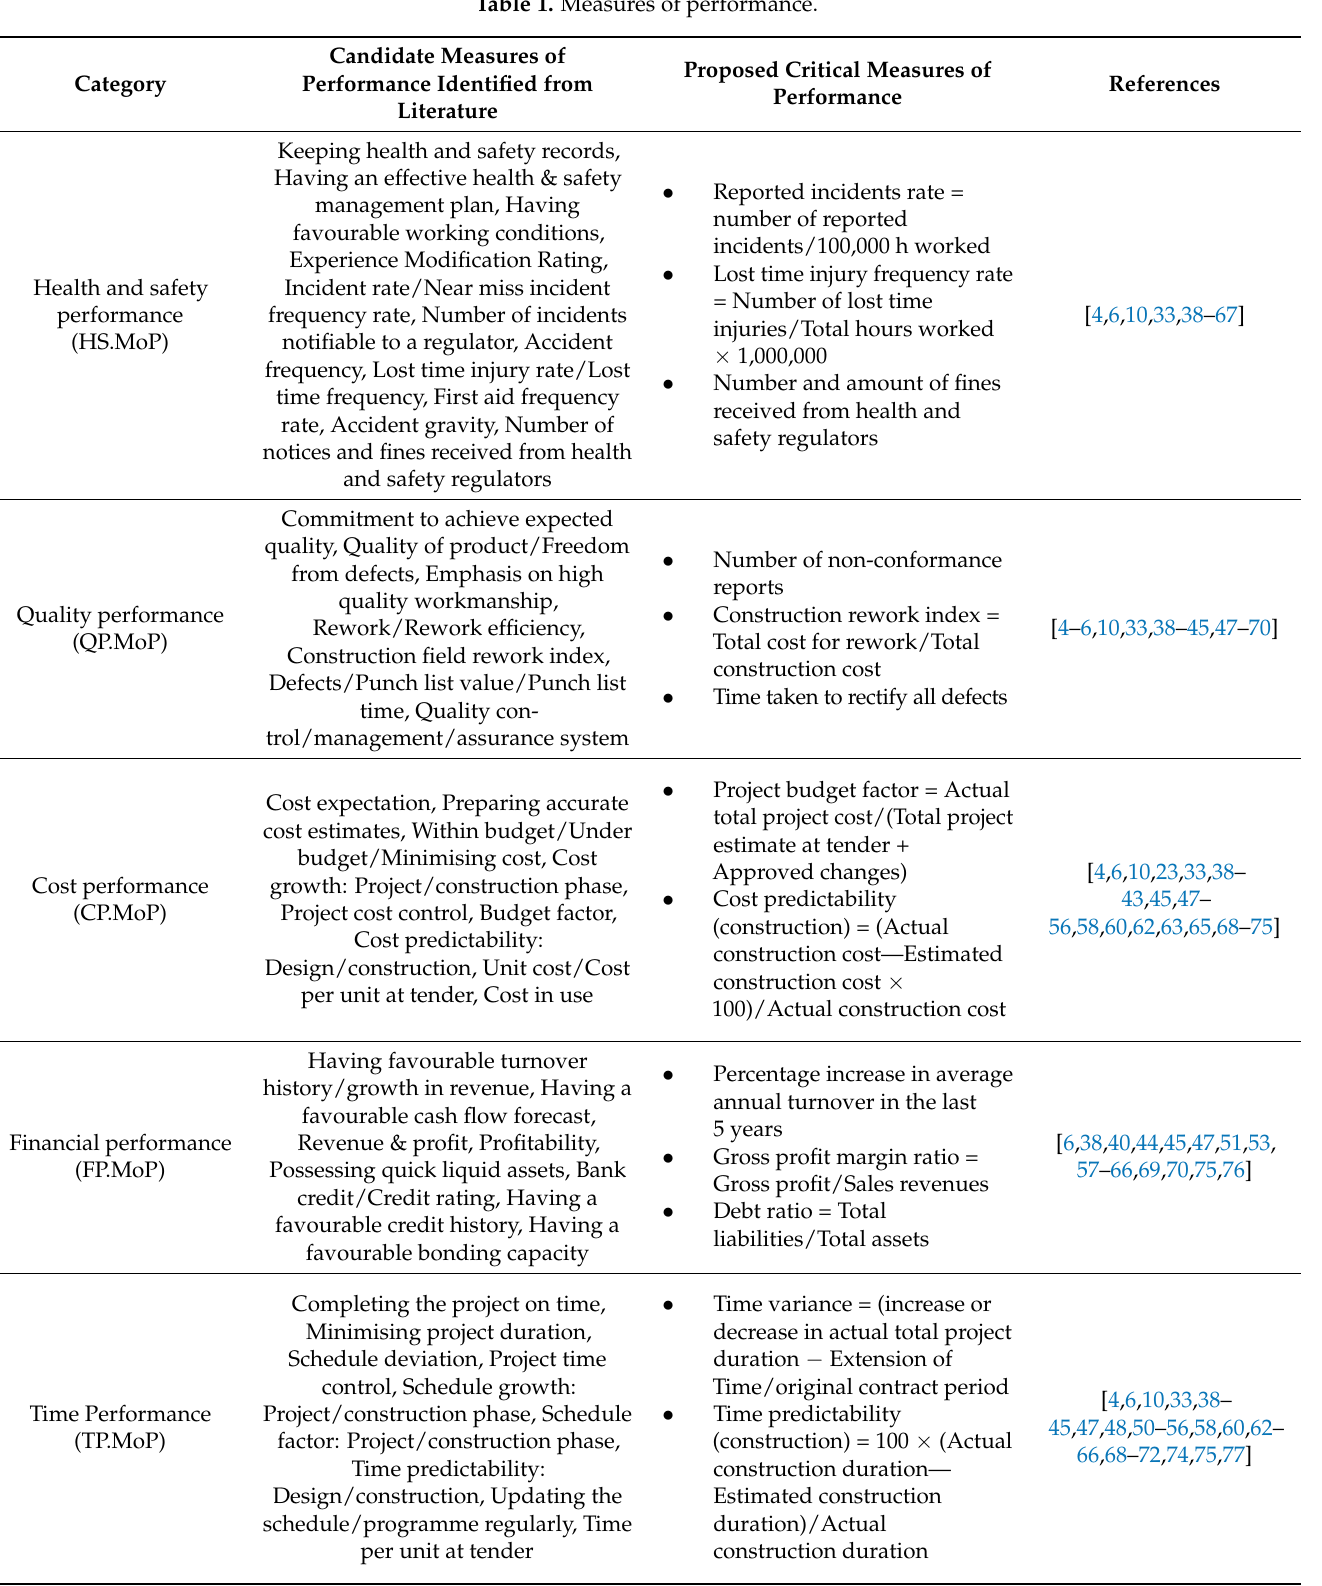
Table 1. Measures of